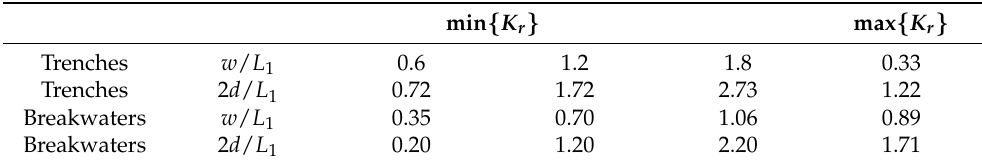
Figure 6. K r versus wave number k 1 h 1 in case of single rectangular ( a ) trench; ( b ) breakwater in the absence of semi-infinite plate with different widths w / L 1 , L 1 = 40 π m. Table 3. Values of w / L 1 , 2 d / L 1 for common min/ max of K r in case N number of trenches/breakwaters.